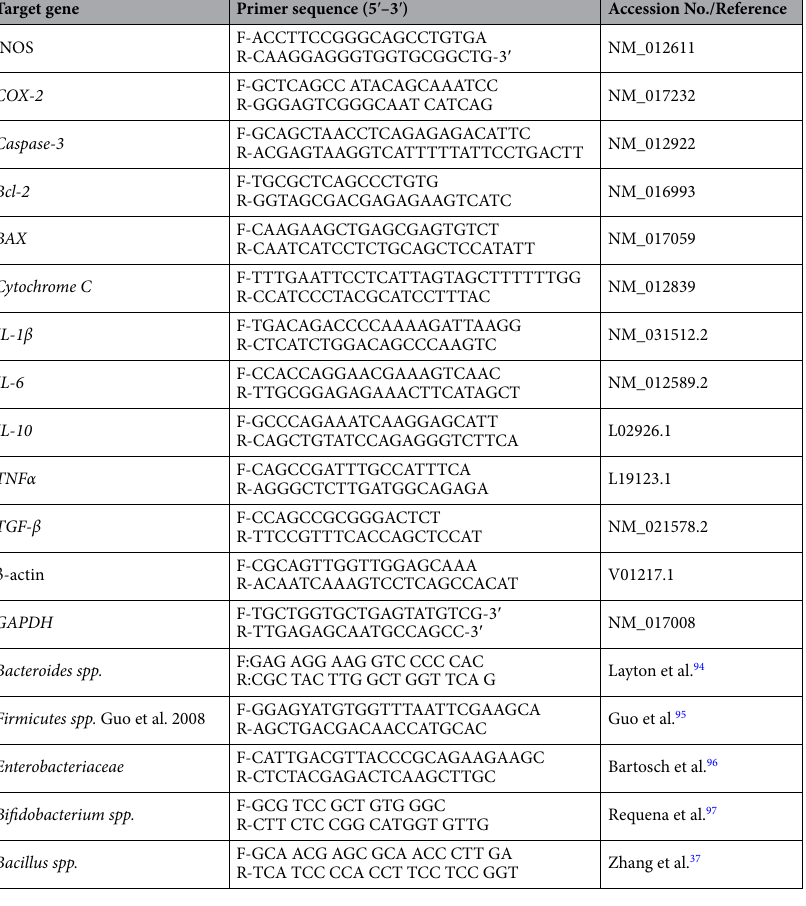
Table 4. Primer sequences utilized for rRT-PCR analysis of targeted gene expression. iNOS inducible nitric oxide synthase, COX-2 cyclo-oxygenase-2, IL interleukin, TNFα tumor necrosis factor α, TGF-β